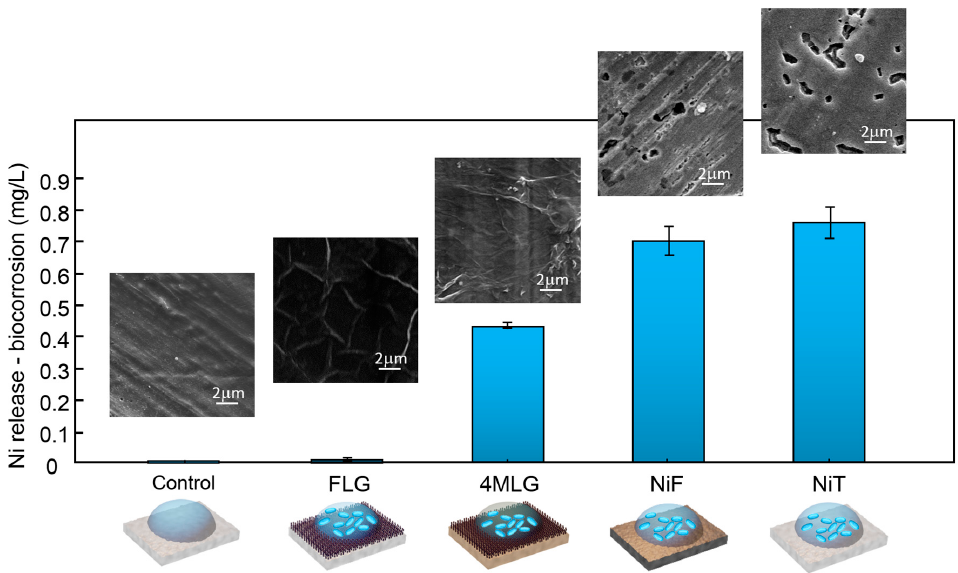
Figure 4. Ni ion release from graphene-coated and uncoated Ni samples. ICP measurements on